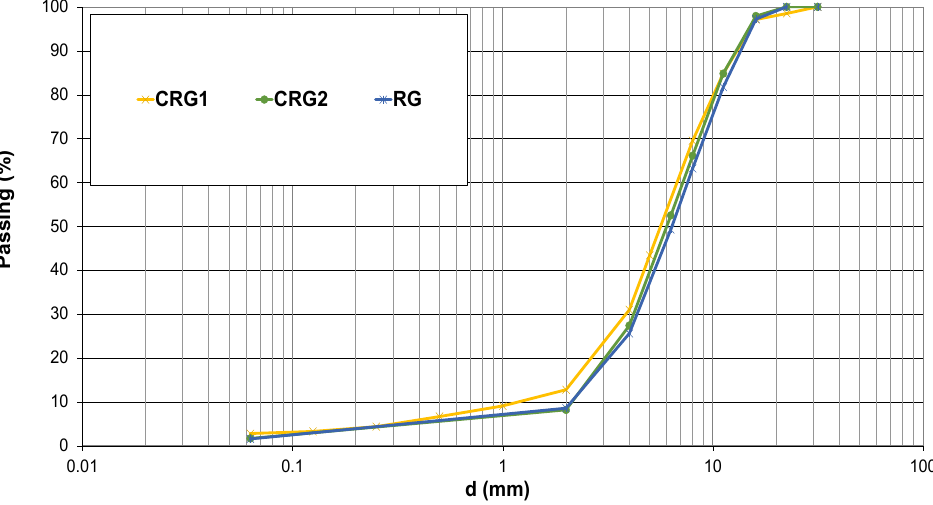
Figure 2. Sieve curves of recycled gravel before and after carbonation according to the two processes; d is the sieve size (passing).